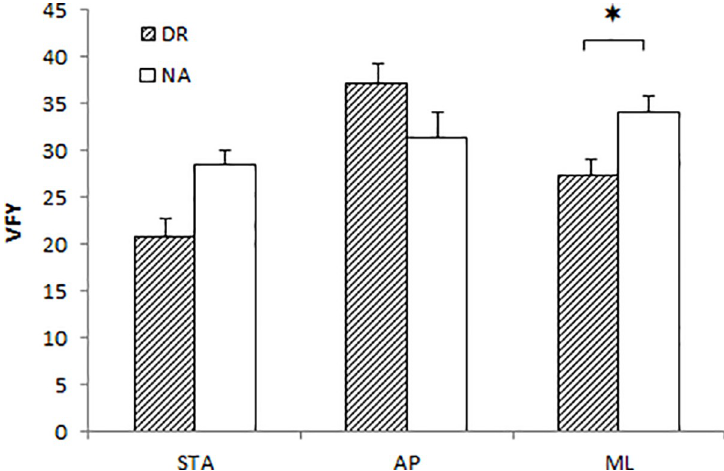
Fig 2. VFY for DR and NA groups across the three balances. Data are presented as mean and standard error. ( � p < 0.05).